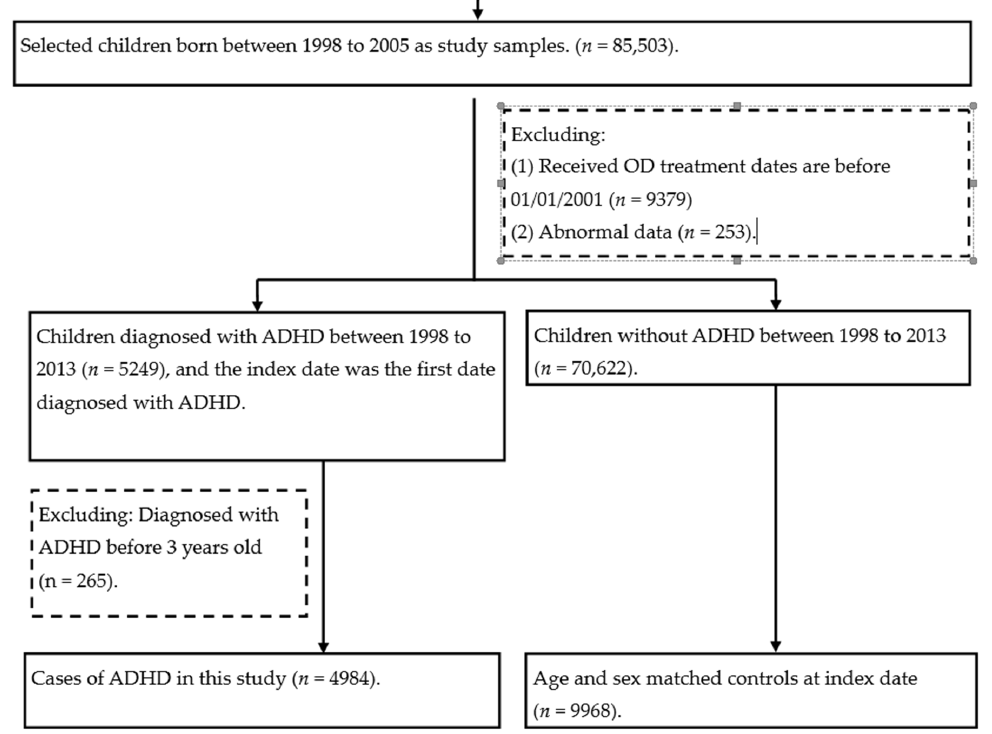
Figure 1. The flowchart of study sample selection from the National Health Insurance Research Database in Taiwan. NHIRD: Taiwan’s National Health Insurance Research